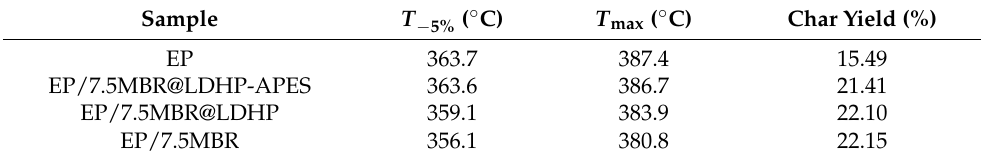
Figure 4. TG ( a ) and DTG (derivative thermogravimetry) ( b ) curves for EP and EP/7.5MBR@LDHP-APES, 264 EP/7.5MBR@LDHP, EP/7.5MBR. Table 3. TG data for EP and its composites.